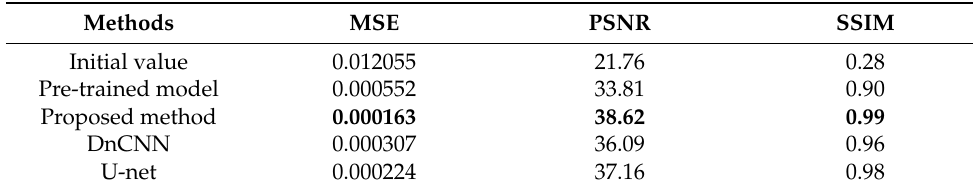
Table 3. Quantitative comparison of the first synthetic